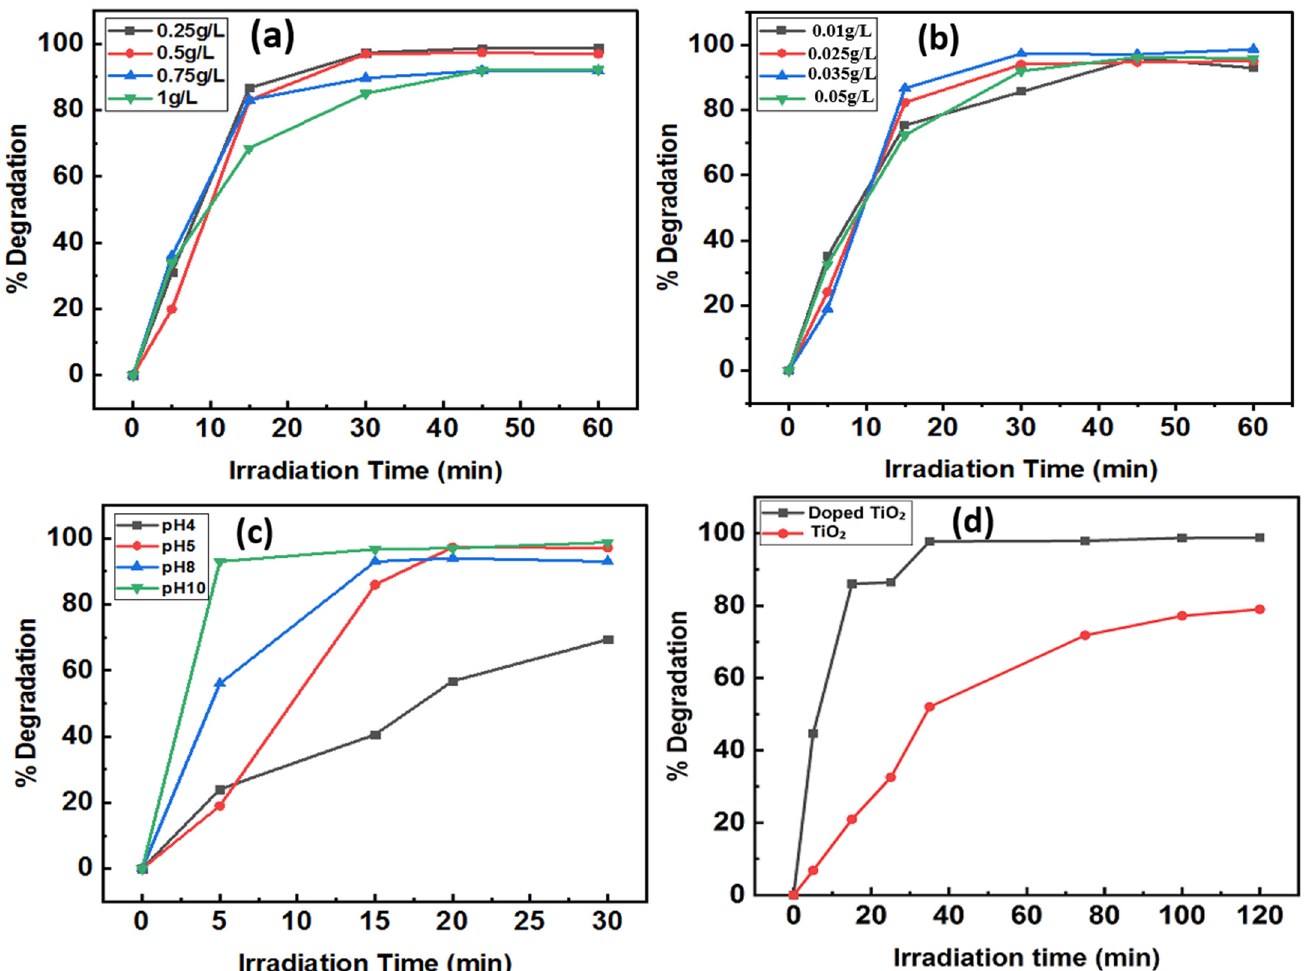
Figure 8. Influence of ( a ) the photocatalysts concentration on the photodegradation mechanism for the decomposition of MG. Experimental conditions: dye concentration (0.25 g·L − 1 ), original pH i.e., 5.2, absorbance was recorded at 618 nm, with continuous stirring, irradiation time as 60 min; ( b ) the dye concentration on the rate of photodegradation for the decomposition of MG; ( c ) the pH on the photodegradation mechanism of MG with concentrations of TiO 2 to be 0.25 g·L − 1 and MG to be 0.035 g·L − 1 ; ( d ) comparison of the rate of photodegradation for the decomposition of MG under TiO 2 and Co-doped-TiO 2 .